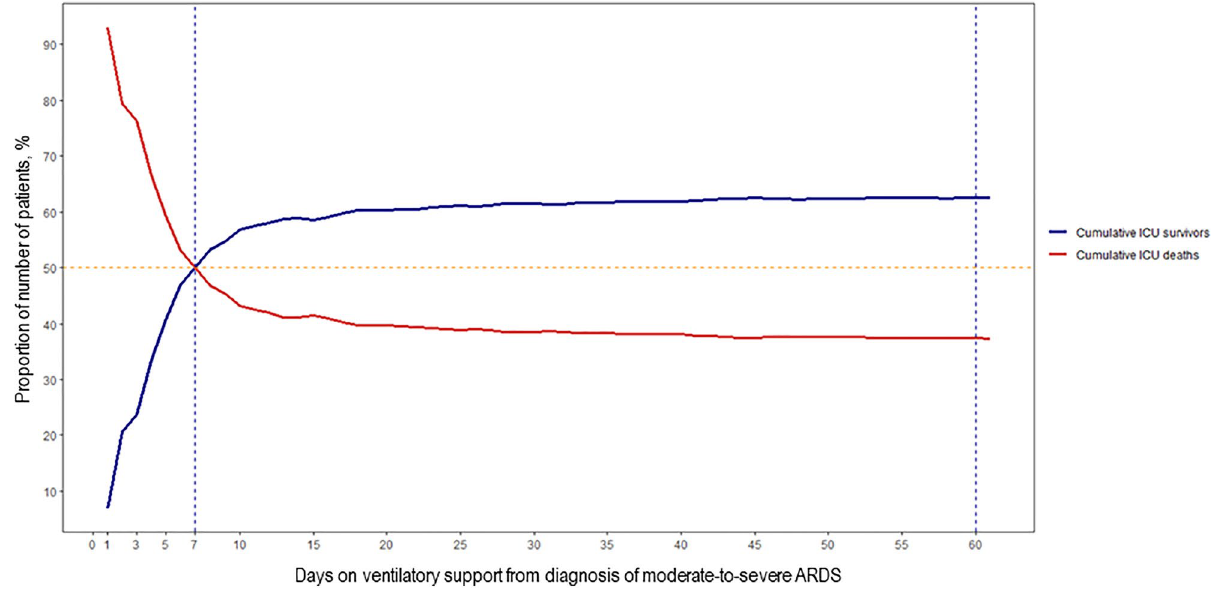
Figure 1. Percentage of cumulative number of survivors and non-survivors in 1303 patients with moderate-to- severe ARDS. Each day represents the cumulative percentage of patients that were ventilated up to that day and were discharged alive or dead from the intensive care unit (ICU), independently of the day on which patients were discharged from ICU (see Supplementary Table S1 for details). Note: from 58 patients on mechanical ventilation for 1 day, 54 patients (93.1%) died in the